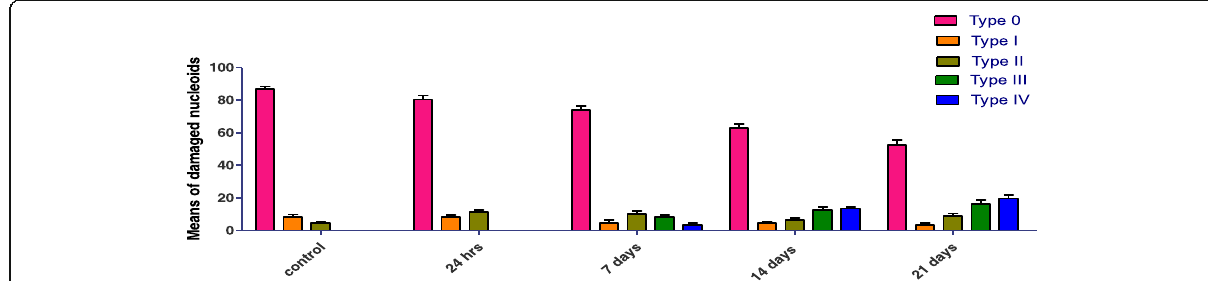
Fig. 7 Graph representing nucleoids in various degrees of damage (mean ± S.D.) in the liver of C. carpio during sub-lethal exposure to karanjin